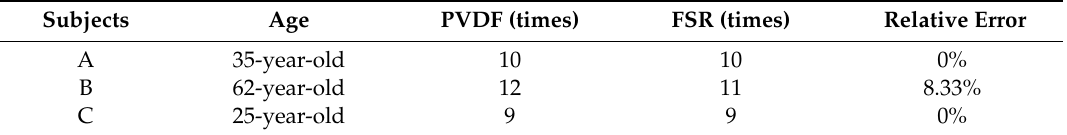
Table 1. Comparison of PVDF system and forward-scattering radar (FSR) system.